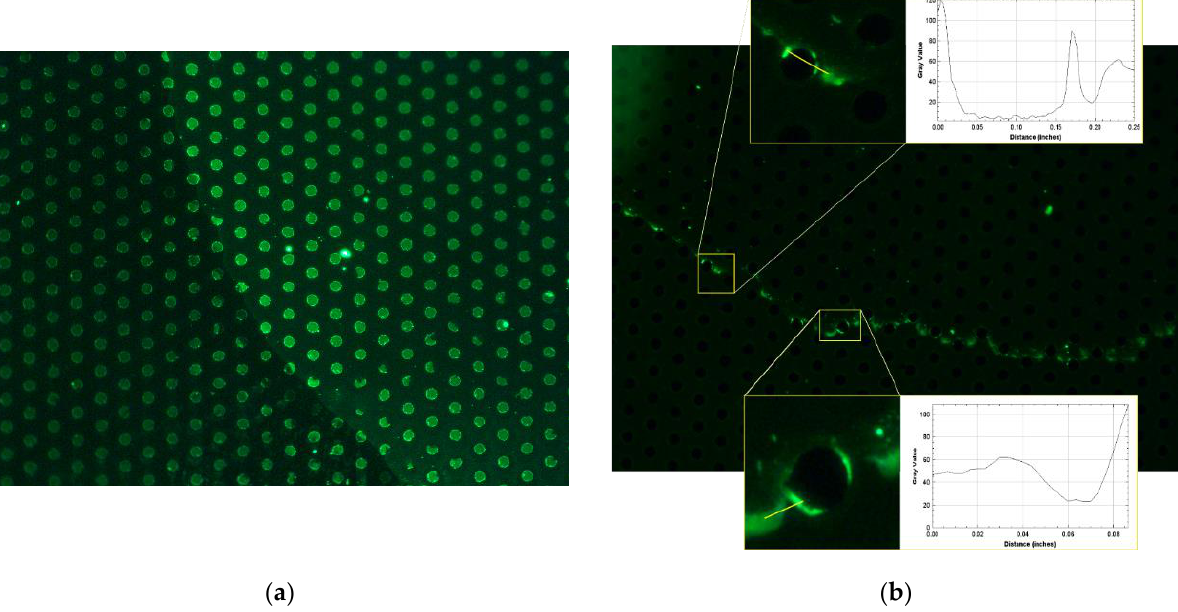
Figure 5. Fluorescent image of washed a Ab FITC drop [1 µg/mL] ( a ) and the lowest concentration recorded [100 fg/mL] ( b ). The zoom areas around the AuNPs islands highlight the MEF effect, evidenced by the intensity value of fluorescence, calculated along the yellow line plot in each zoom.